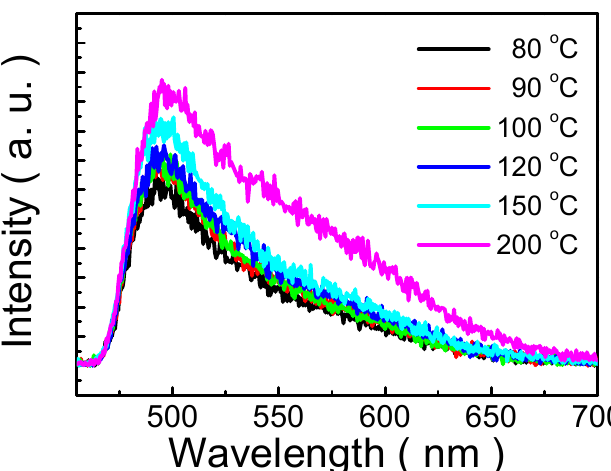
Figure 6. PL spectra of MP1D films annealed at various temperatures (80, 90, 100, 120, 150, and 200 °C).